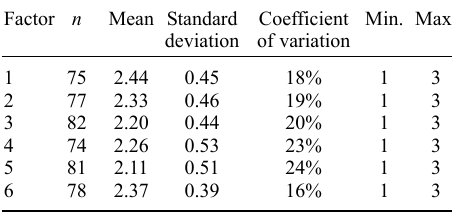
Standard deviation of factors Factor n Mean Standard Coefficient Min. Max. deviation of